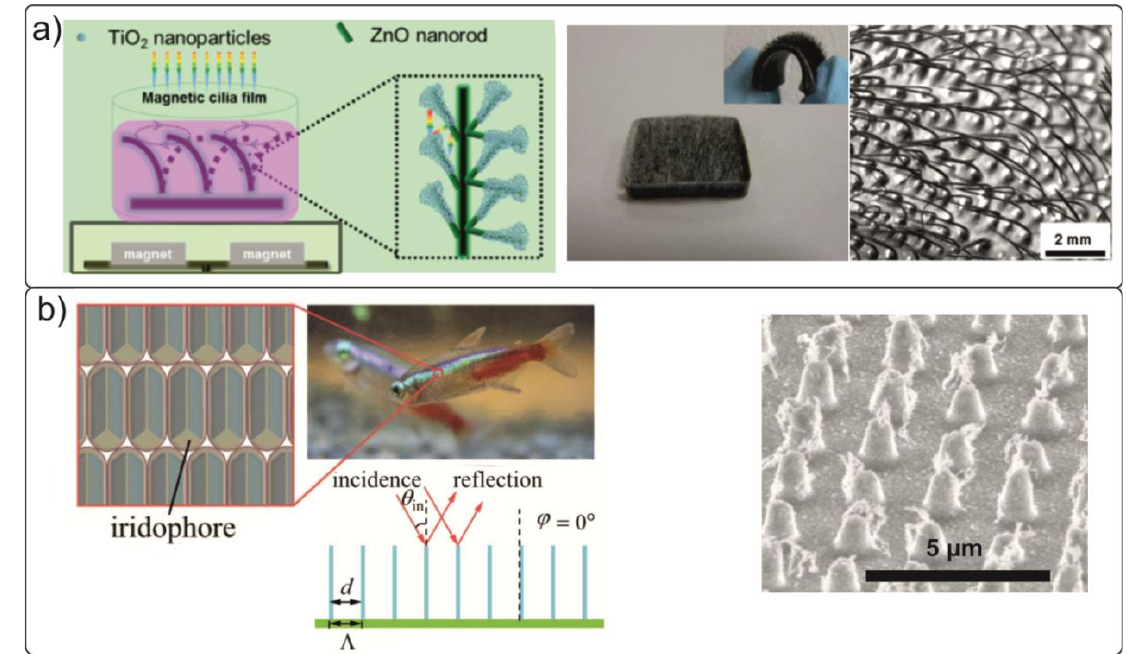
Figure 15. ( a ) Schematic and photo of ZnO/TiO 2 ciliated films (a bent specimen is shown in the inset). The photo on the right shows the bending of ZnO/TiO 2 cilia under the action of an external magnetic field [155]. ( b ) Schematic representation of a neon tetra fish and SEM photo of the artificial photonic structure fabricated in [156]. Copyright 2012, American Chemical Society.